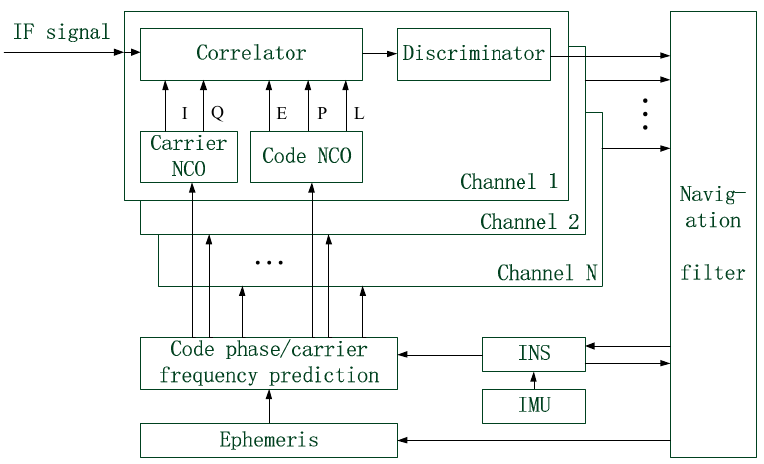
Figure 1. The structure of deep GNSS (Global Navigation Satellite System)/INS (Inertial Navigation System) integration.